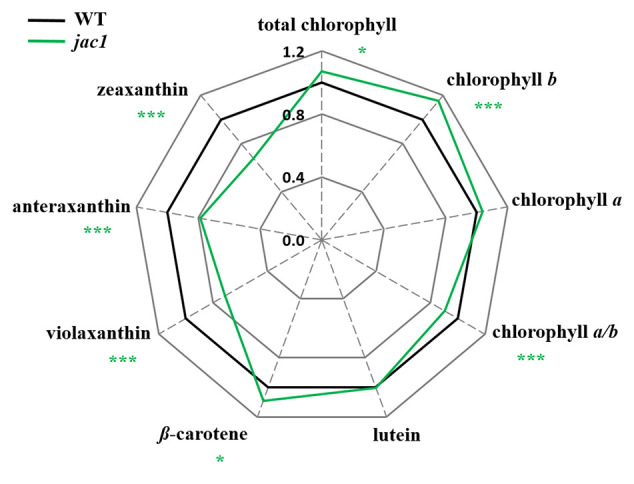
Photosynthetic pigment contents in 4-week-old Arabidopsis thaliana wild type and mutant plants. Total chlorophyll, chlorophyll a, chlorophyll b, chlorophyll a/b ratio; lutein; β-carotene; violaxanthin; antherxanthin; zeaxanthin. Values are means (± SD) of 12 plants per genotype from two independent experiments (n=12) expressed as the peak area (mg of dry weight-1). Asterisks indicate significant differences from the wild type according to the Tukey HSD test at the level of P < 0.05 (*), or P < 0.001 (***).